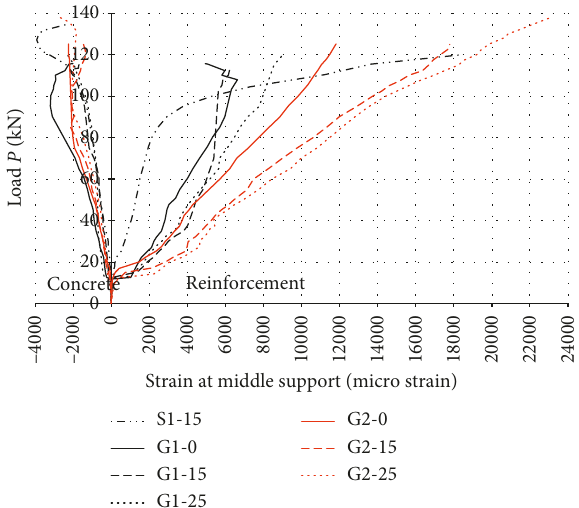
Figure 12: Load-strain relationship at the middle support for tested